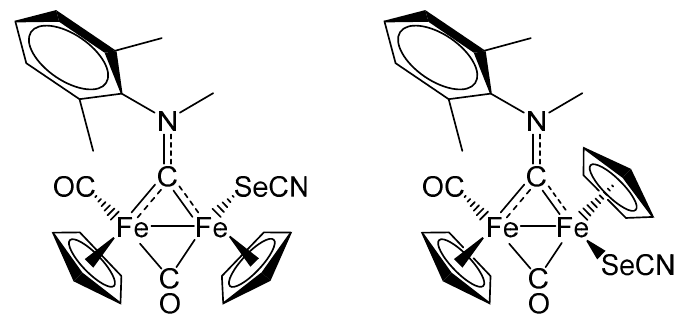
/cm − 1 = 2112 m (SeCN), 2068 w, 1970 vs-br (CO),